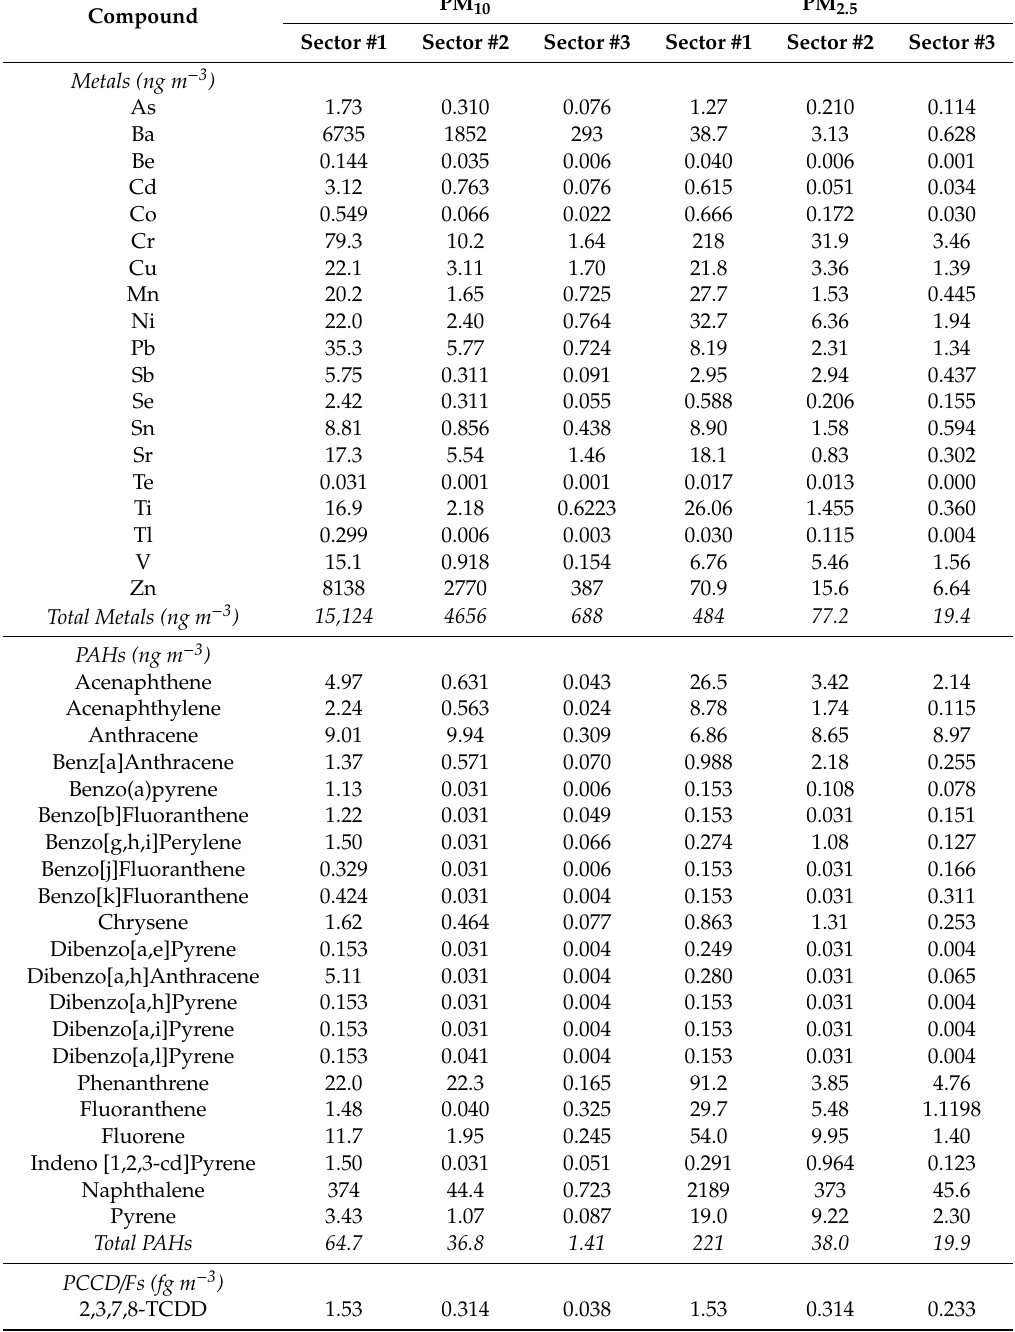
Table 2. Levels of Metals, Polycyclic Aromatic Hydrocarbons (PAHs), Polychlorinated dibenzodioxins and Polychlorinated dibenzofurans (PCDD / Fs) and Polychlorinated biphenyls (PCBs) determined in downtown (site